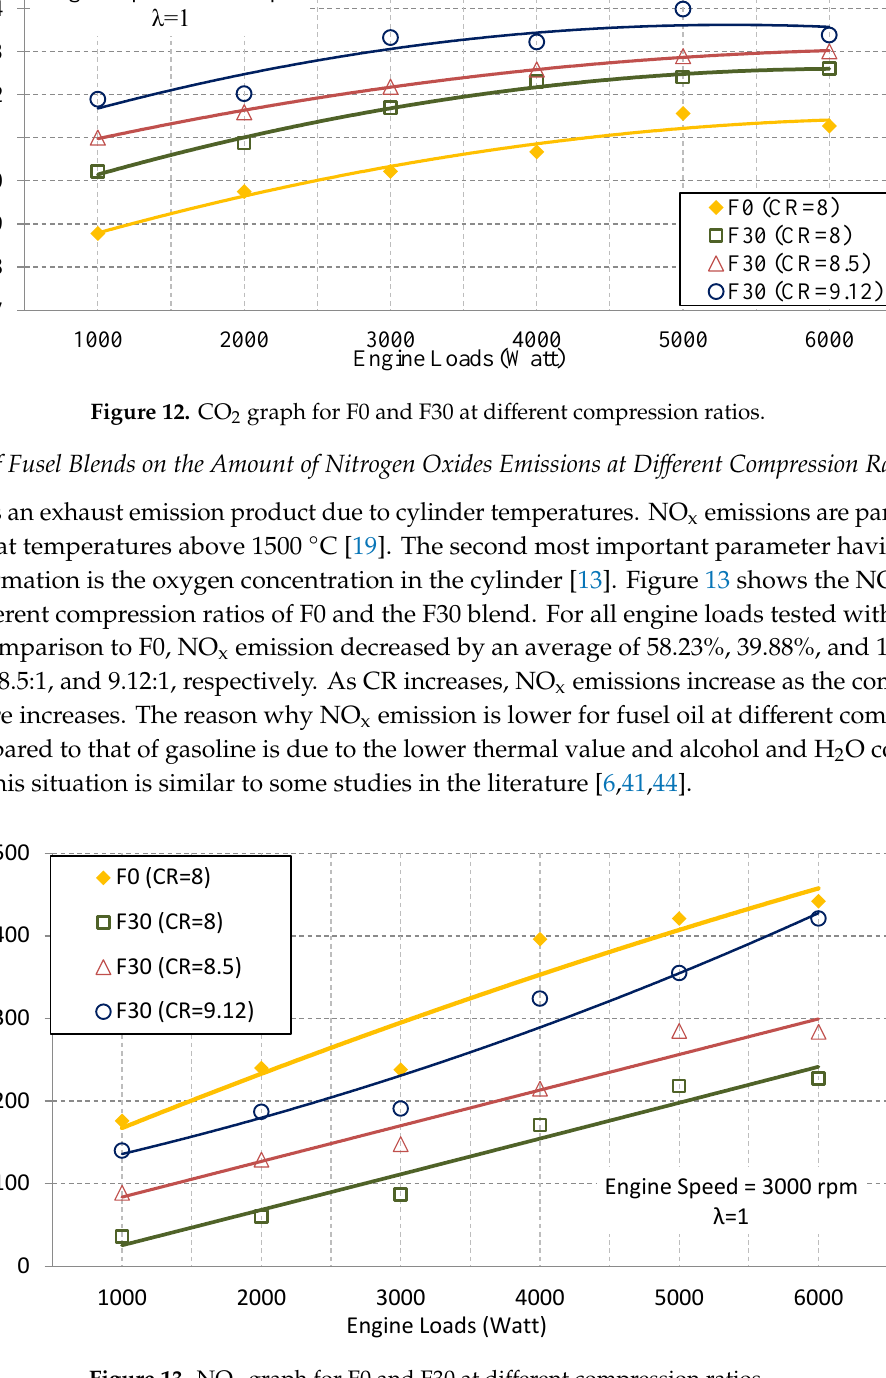
ff erent compression Figure 13. NO x graph for F0 and F30 at different compression ratios. Figure 13. NO x graph for F0 and F30 at di Figure 13. NO x graph for F0 and F30 at different compression ratios.